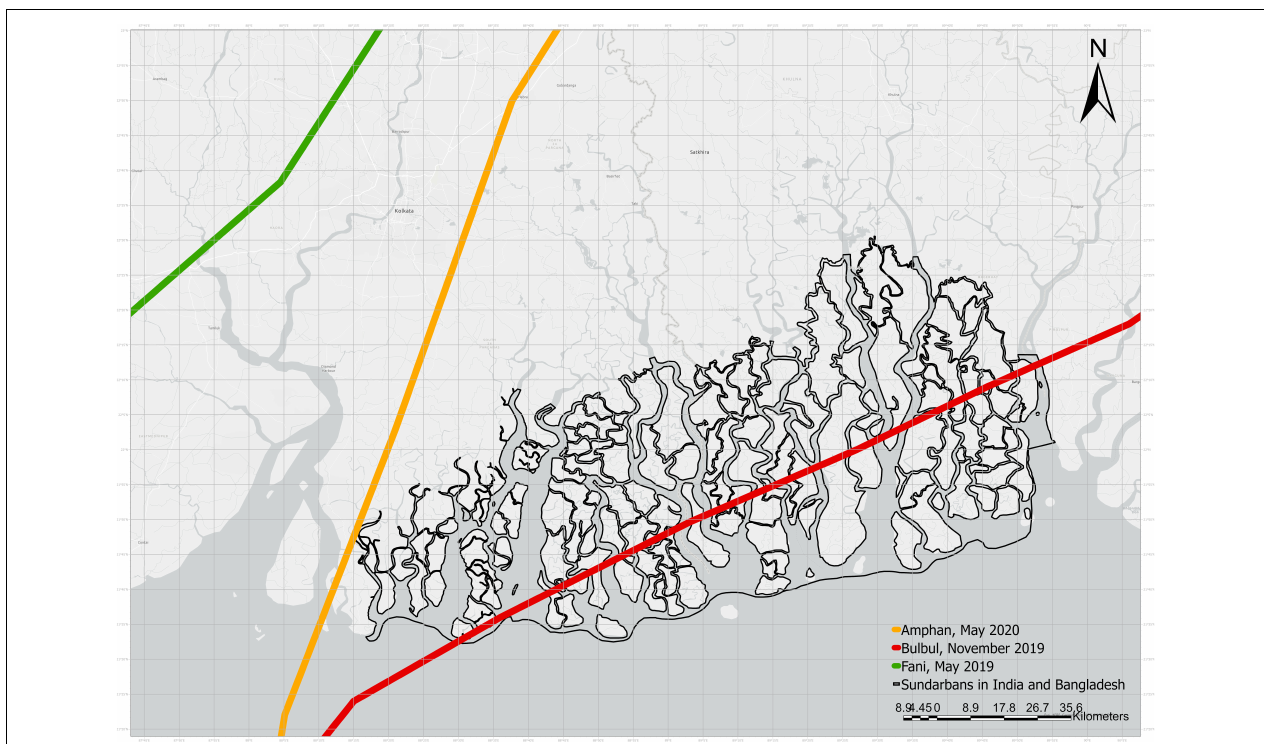
FIGURE 1 | Cyclone distribution and occurrence across the Sundarbans in India and Bangladesh. The white dot on the inset map is the location of the Sundarbans in India and Bangladesh. The gray lines are the trajectory of Cyclone Fani (Category 4, 3-min sustained highest winds: 215 km/h, 1-min sustained highest winds